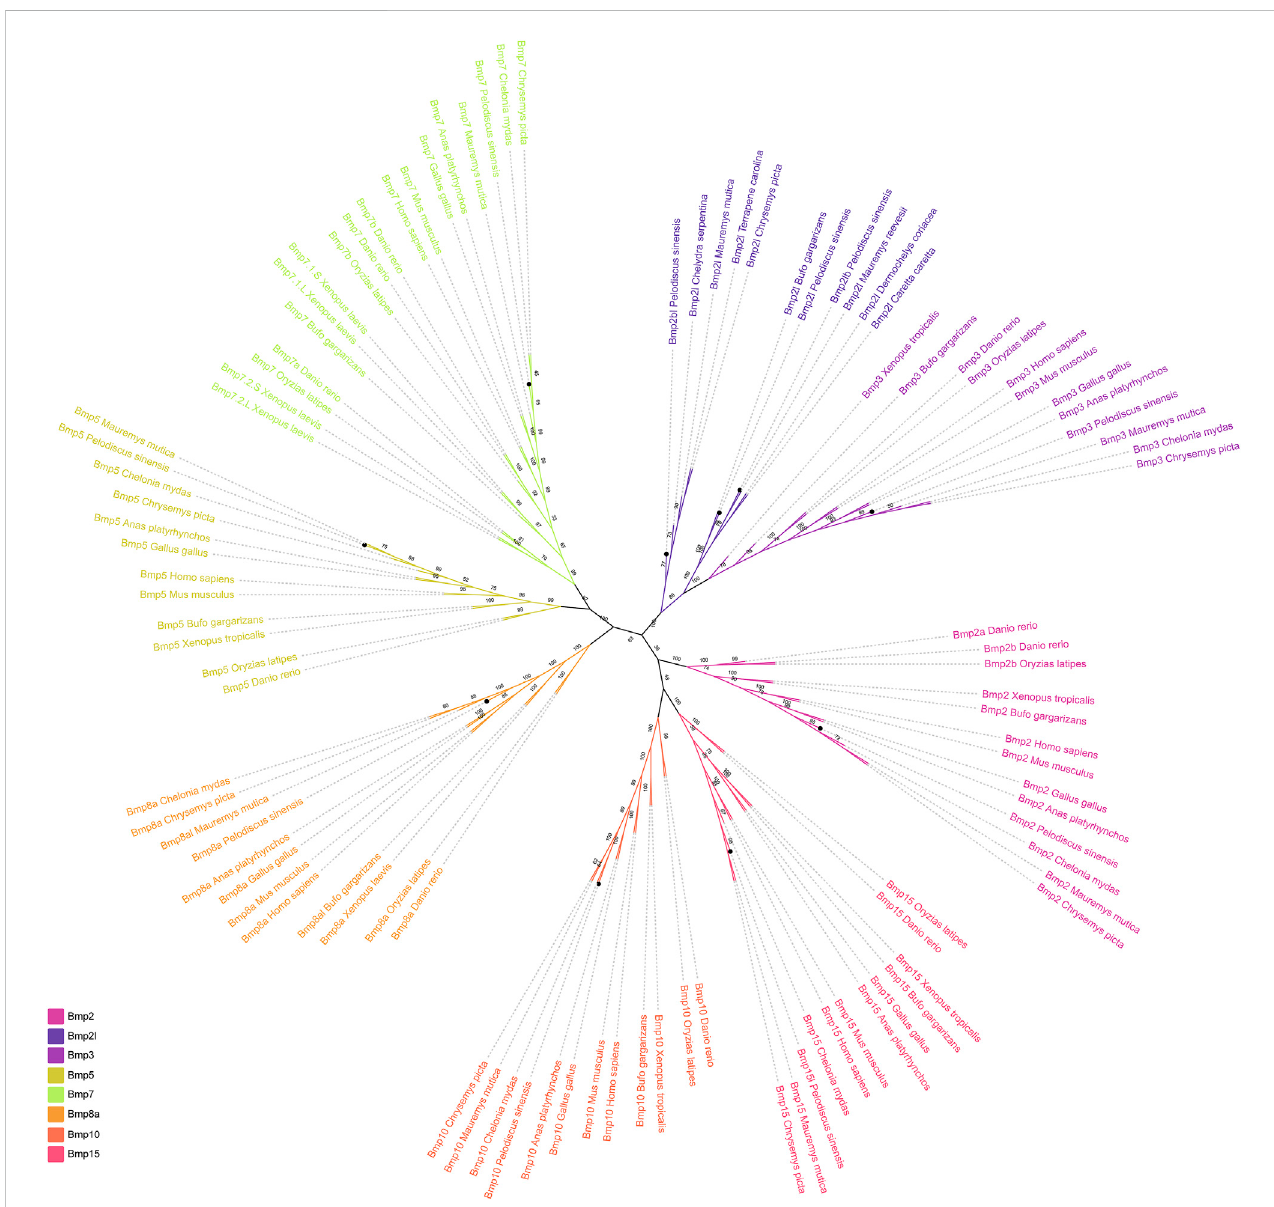
FIGURE 1 Phylogenetic tree of the BMP gene family among different vertebrates. Different colors represent different BMP gene subfamilies. The black circles indicate the BMP genes in P. sinensis.